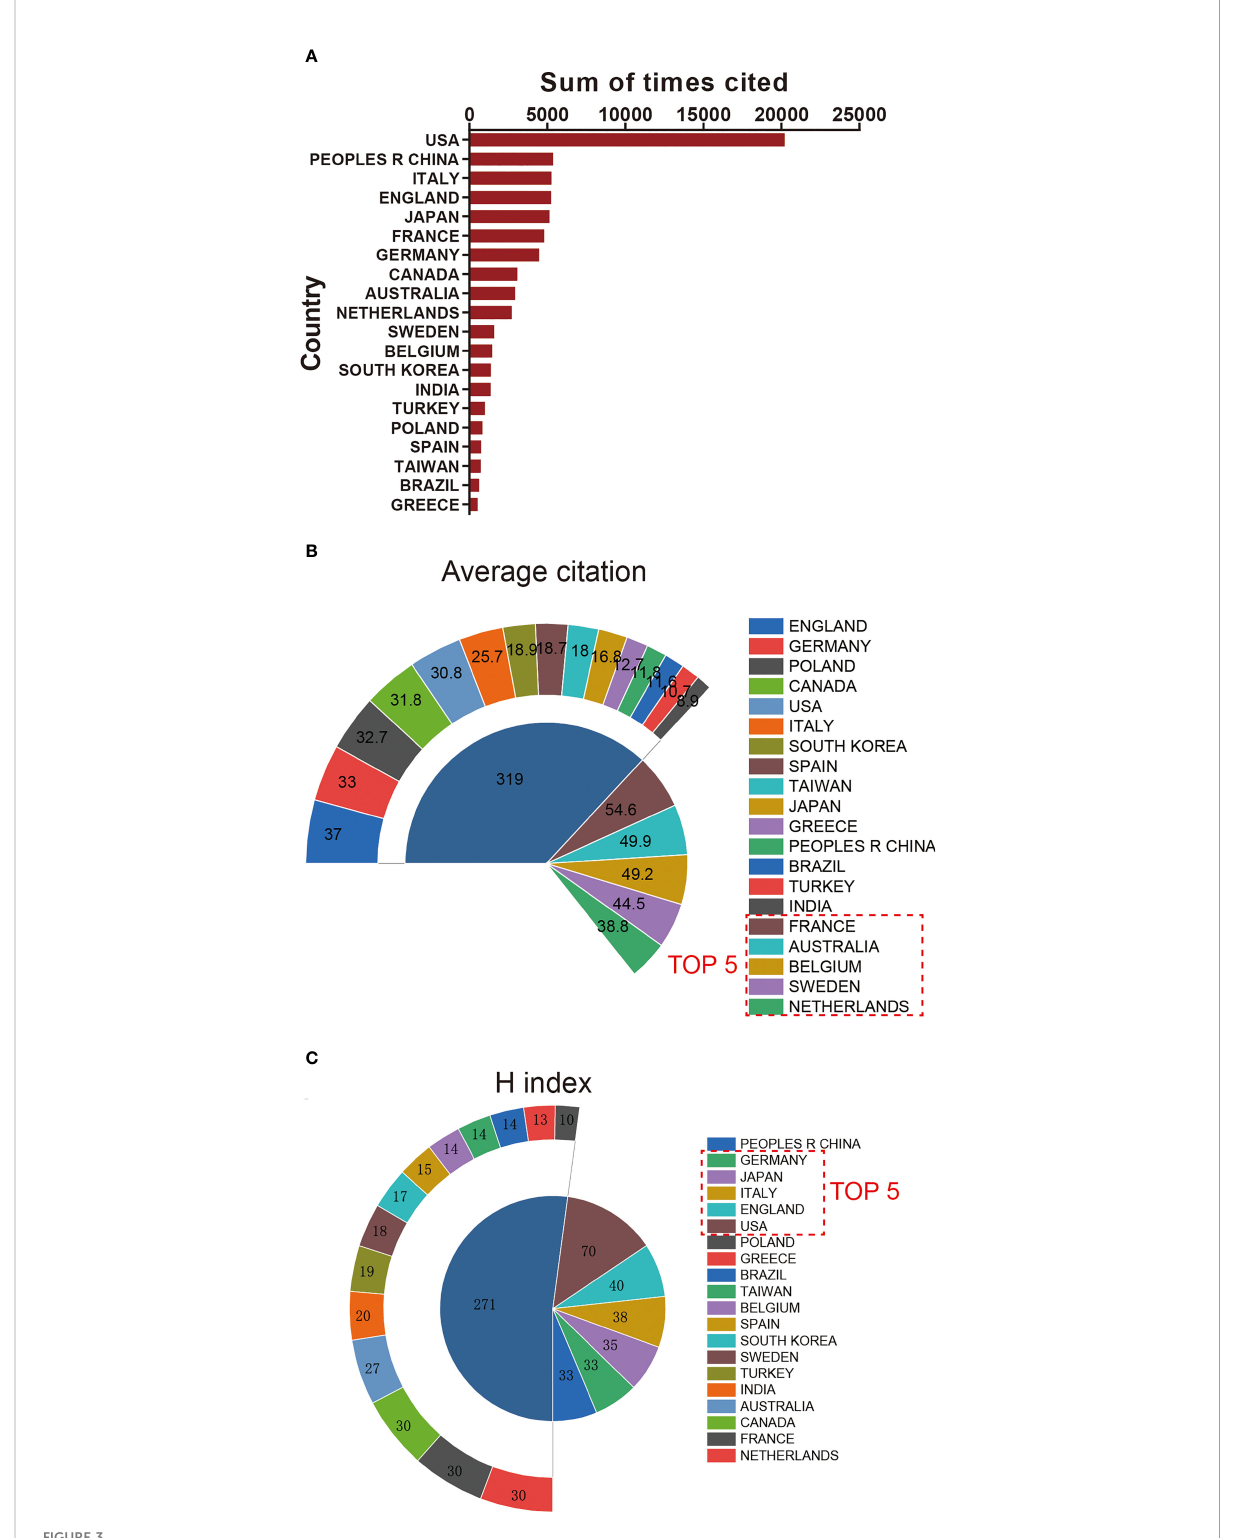
FIGURE 3 Total citation, H index, and citation frequency levels of different countries/regions. (A) The top 20 countries/regions of total citations of giant cell tumor of bone. (B) The top 20 countries/regions of the average citations per paper of giant cell tumor of bone. (C) The top 20 countries/ regions of the H-index of organoids in giant cell tumor of